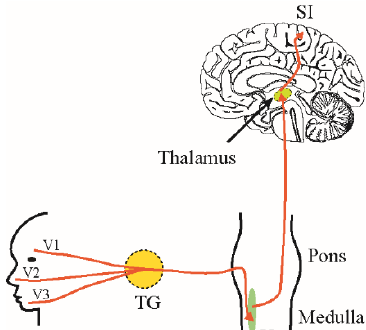
Figure 1. Trigeminal pain pathway. Pain sensation from face and mouth is carried by three peripheral nerve branches (V1, V2 and V3) of trigeminal nerve whose cell bodies sit in trigeminal ganglion (TG) and project centrally to synapse with the second order neurons in the trigeminal spinal nucleus caudalis (V C ). The second order neurons then ascend to terminate in thalamus. From thalamus, nociceptive information is projected to primary somatosensory cortex (SI) where pain processing occurs. Abbreviations: V1: ophthalmic branch; V2: Maxillary branch; V3; mandibular branch of trigeminal nerve.